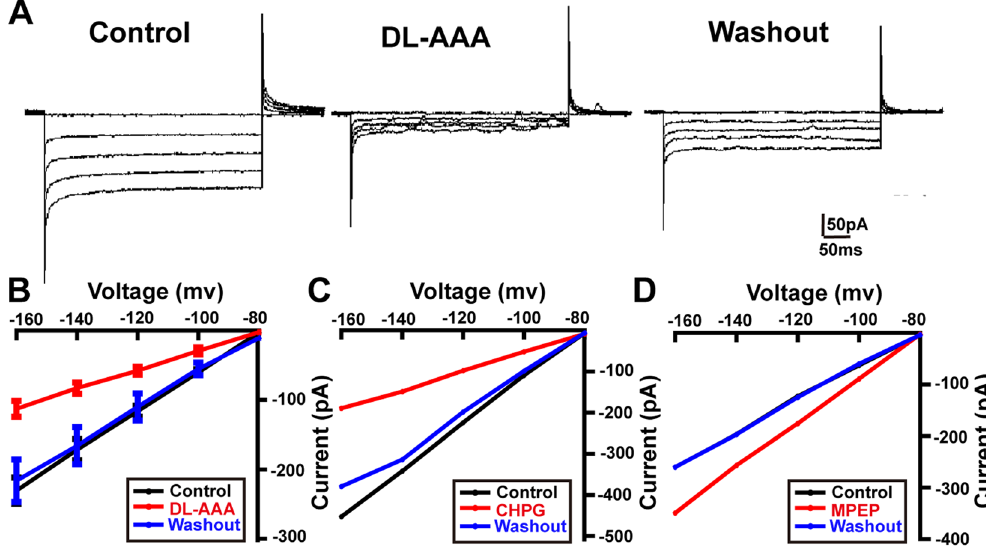
Figure 6. The effects of DL-AAA, CHPG and MPEP on K ir currents of Müller cells. ( A ) Representative whole- cell current traces (under voltage clamp) of cultured Müller cells treated with DL-AAA (in the extracellular medium) at voltage steps of − 160 mV, − 140 mV, − 120 mV, − 100 mV and − 80 mV. ( B ) Mean I–V relationships of cultured Müller cells treated with DL-AAA in the extracellular medium( red ), and after washout ( blue ). ( C ) The same as ( B ) but for CHPG. ( D ) The same as B but for MPEP. Line charts show means ± SEM.